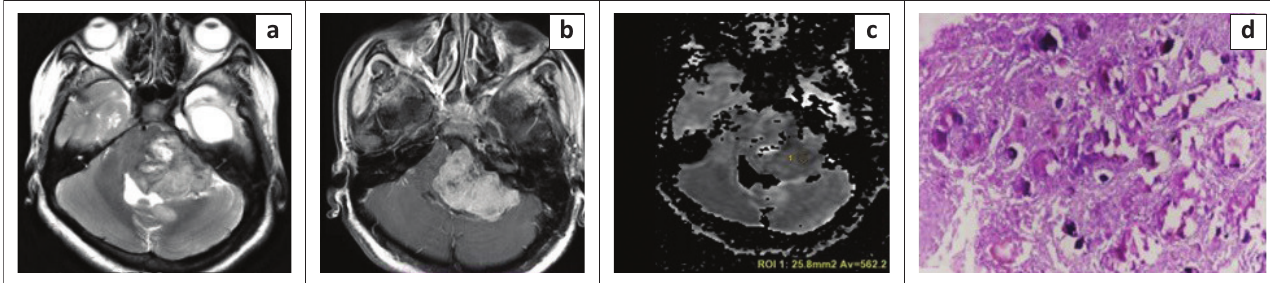
FIGURE 3: Images of a 20-year-old female who presented with bilateral hearing loss. A well-defined lobulated extra-axial lesion is seen in the left cerebellopontine angle region. The lesion is heterogeneously hyperintense on axial T2WI (a). It is causing mass effect on the 4th ventricle with resultant upstream dilatation of ventricular system. The dilated temporal horn of left lateral ventricle is seen on axial T2WI (a). The lesion shows heterogeneous post-contrast enhancement (b) which is a typical feature of transitional meningioma. Low apparent diffusion coefficient values (c) are seen. The patient underwent surgery and histopathological photomicrograph (d) illustrated tumour comprised of syncytia of epithelial cells with prominent psammoma bodies confirming the transitional subtype of meningioma (Hematoxylin and eosin staining,